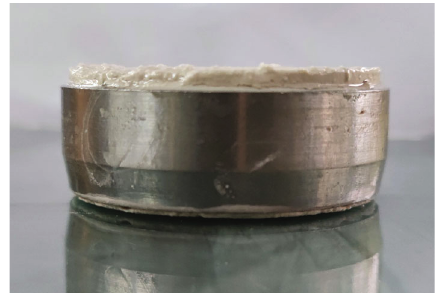
Figure 11: After the con fi ned expansion.